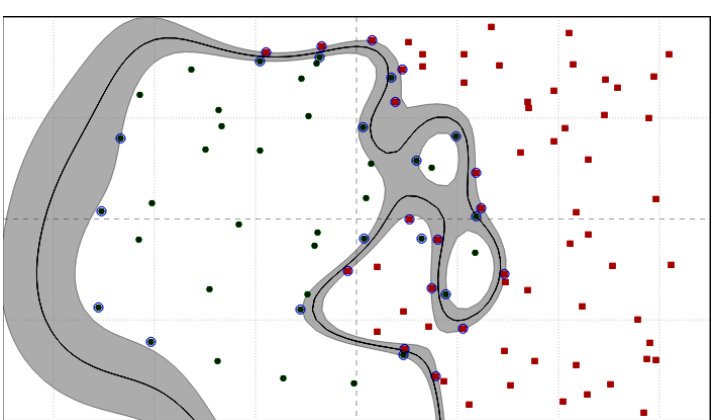
Figure 7. SVM with RBF ( γ =